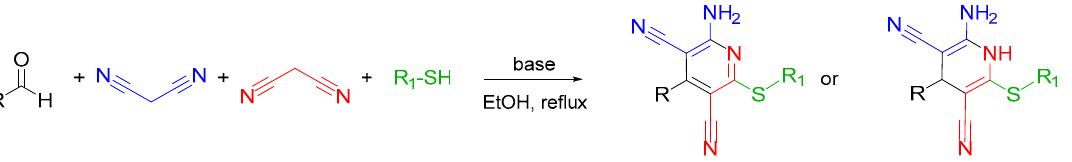
Scheme 2 : Synthesis of the 2-amino-3,5-dicyano-6-sulfanylpyridines via the single-step, three- component reaction.